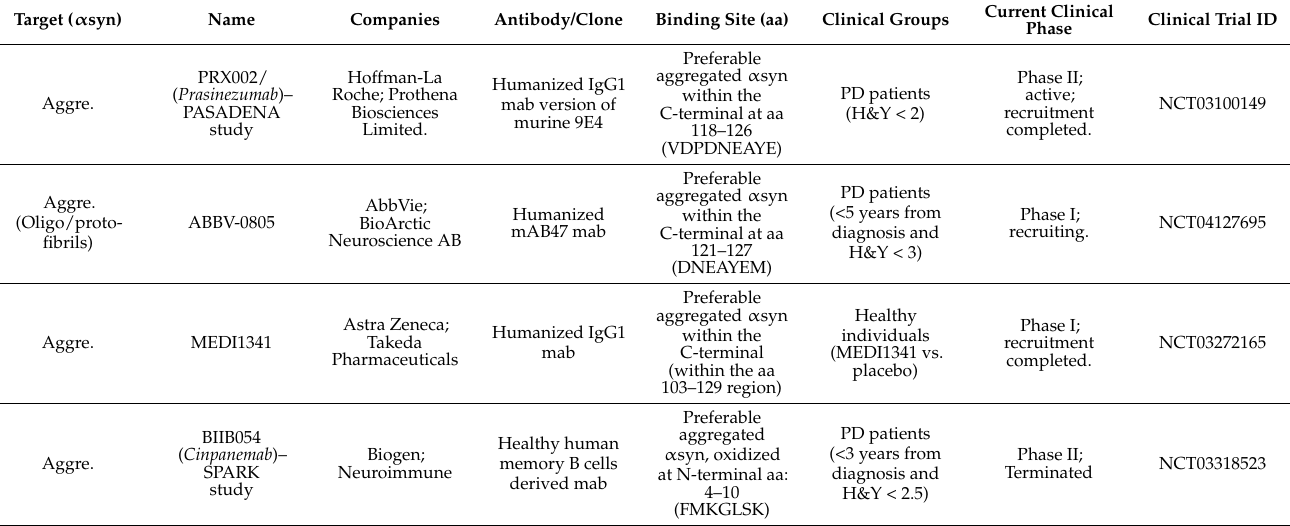
Table 2. Passive immunization candidates currently in clinical